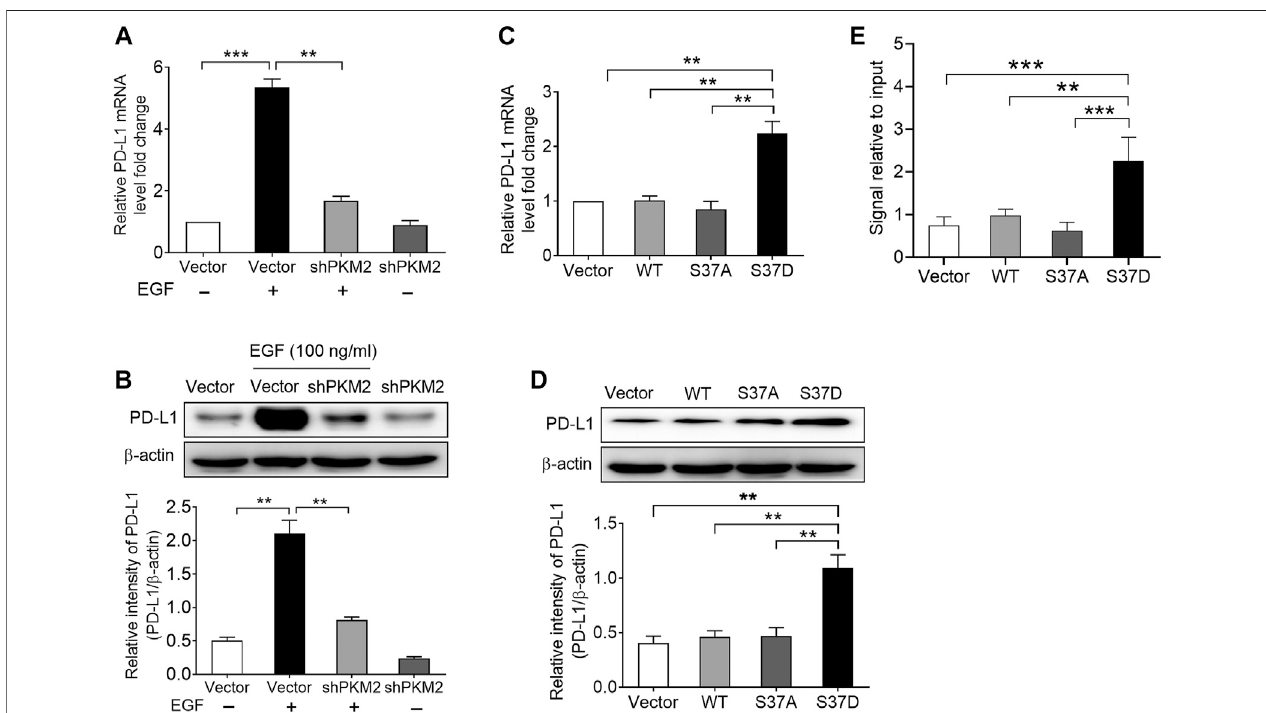
FIGURE 4 | Phosphorylation of PKM2 at Ser37 participates in EGF-induced PD-L1 expression. (A,B) PKM2 shRNA blocked EGF-induced PD-L1 mRNA (A) and protein (B) expressions in SNU-368 cells. At 24 h post-transfection, the cells were incubated in the presence or absence of 100 ng/ml EGF for 12 h. **p < 0.01, ***p < 0.001, one-way ANOVA, n (cid:1) 4 independent experiments per group. (C,D) The expression of a phosphorylation-mimic PKM2 S37D mutant induced a higher expression of PD-L1 mRNA (C) and protein (D) compared with WT PKM2 or the S37Amutantin SNU-368 cells. **p < 0.01, one-way ANOVA, n (cid:1) 4 independent experiments per group. (E) ChIP analyses showed that the expression of a phosphorylation-mimic PKM2 S37D mutant resulted in increased binding of PKM2 to PD-L1 promoter in SNU-368 cells. *p < 0.05, **p < 0.01, one-way ANOVA, n (cid:1) 5 independent experiments per group.